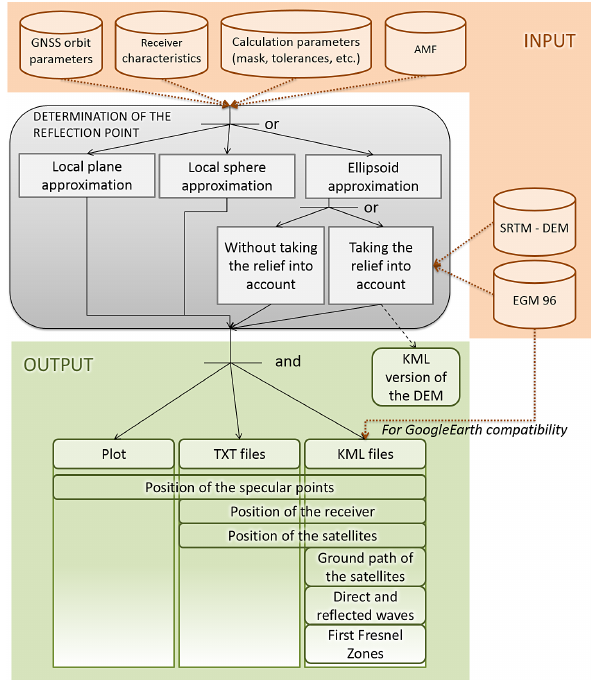
Figure 2. Data flowchart of the simulator. Three main blocks: an input block that contains the different elements mandatory for the processing, a processing block where the user can choose which algorithm is to be used, and an output block containing the differ- ent results of the simulation, namely KML files to be opened with Google